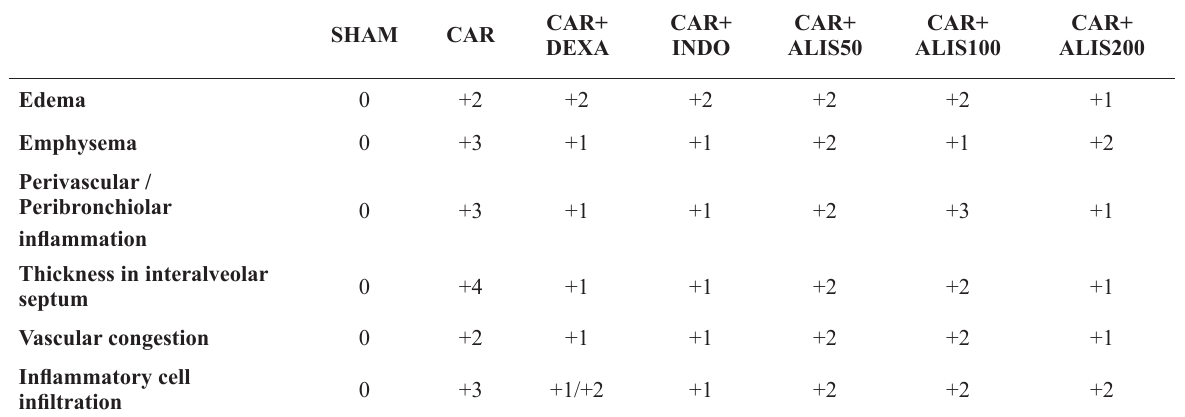
Histopathological assessments of